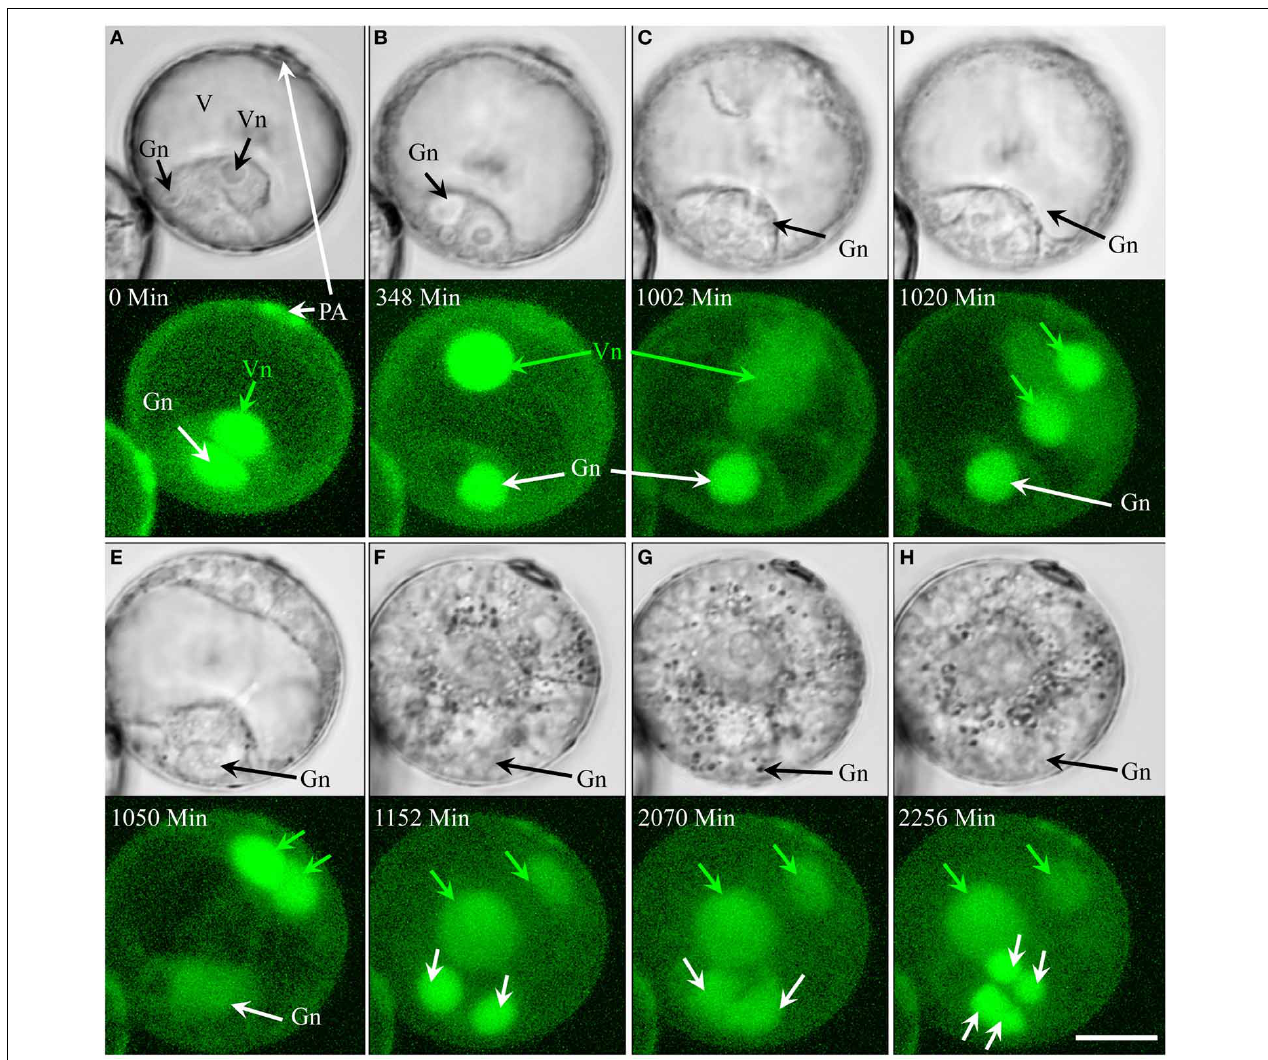
FIGURE 5 | Time-lapse of type VI (non-embryogenic pollen). Development shown by synchronously acquired DIC and fluorescence images of GFP. Green arrows indicate vegetative-like nucleus and its daughter nuclei. White arrows indicate generative-like nucleus and its daughter nuclei (A,B) . Asymmetric division resulted in a large vegetative-like and a small generative-like cell. (C,D) First mitosis of the vegetative nucleus; the spherical generative-like nucleus